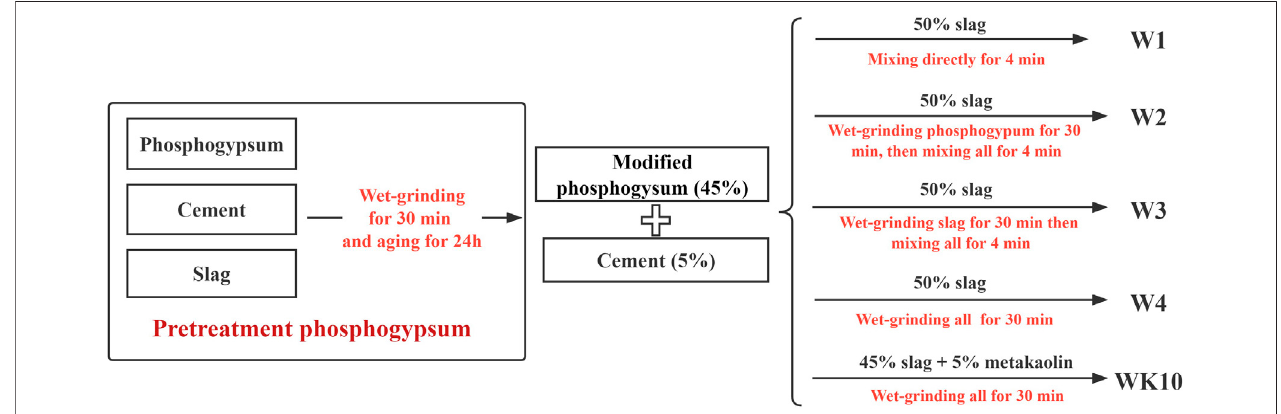
FIGURE 2 | P-SSC paste preparation process in this